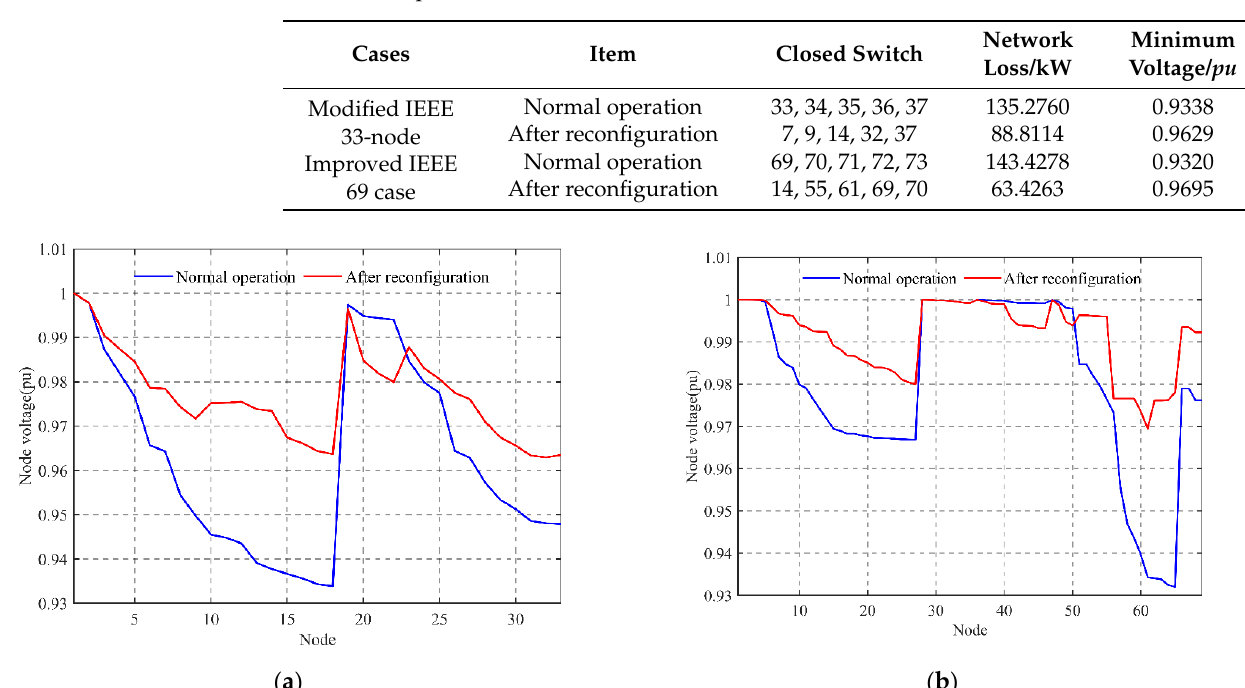
Figure 5. Voltage comparison of each node before and after DNR. ( a ) Improved IEEE 33 nodes; ( b ) improved IEEE 69 nodes.